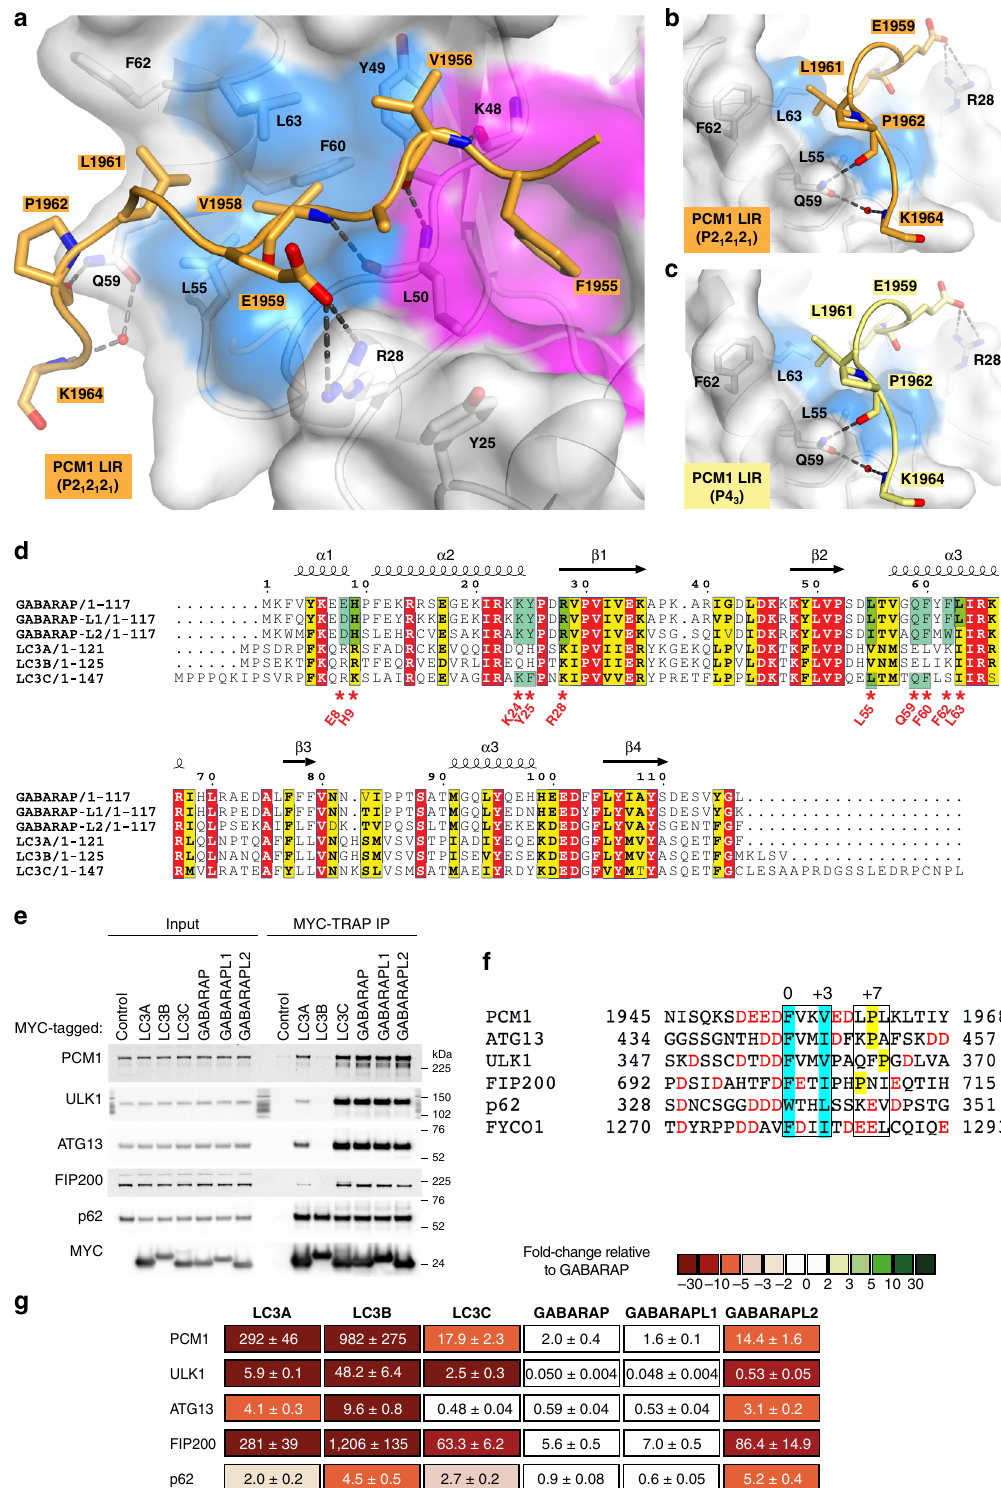
LC3B (4.5 µM) and GABARAP-L2 (5.2 µM) was fi ve-fold weaker than to GABARAP (0.9 µM); however, these differences in binding are not detected in MYC-Trap immunoprecipitation (IP) experiments (Fig. 1e), where p62, due to PB1 domain- mediated polymerization, binds strongly to all mammalian ATG8 proteins 14 . The binding speci fi cities of ULK1, ATG13,